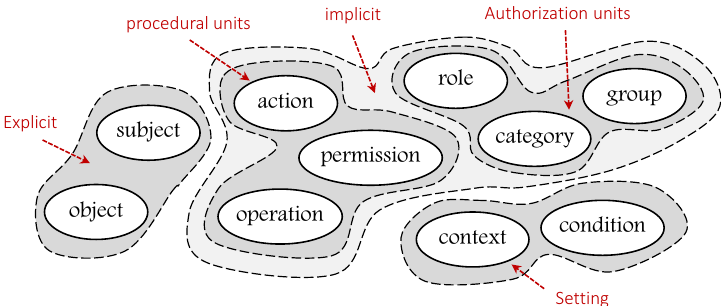
Figure 2. Unifying heterogeneous concepts of AC models.